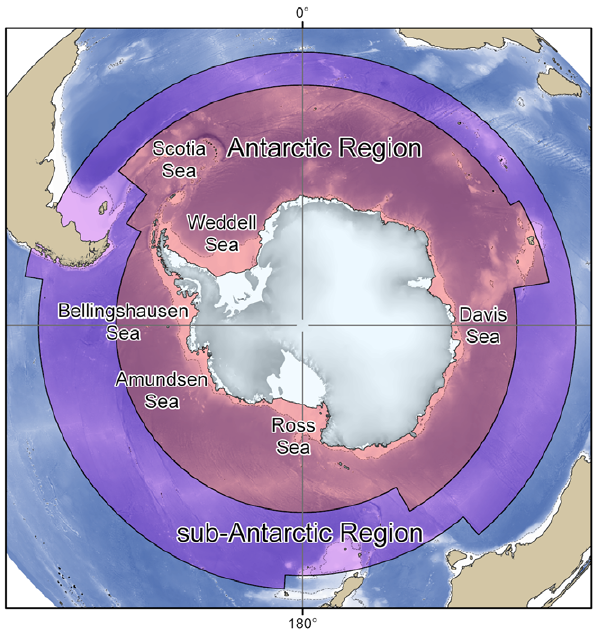
Figure 1. The SCAR-MarBIN/CAML areas of interest.